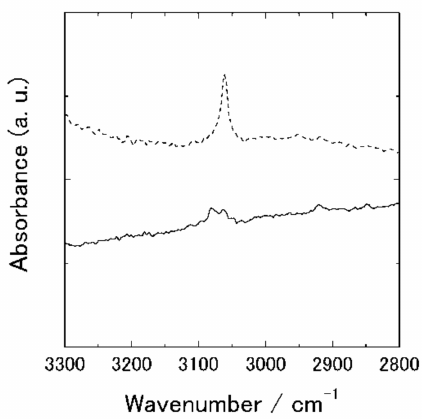
Figure 4. Polarized transmission IR spectra in the C–H stretching region of the friction-transferred PT film. The polarization direction in transmission spectra is parallel (solid line) and perpendicular (dashed line) to the drawing